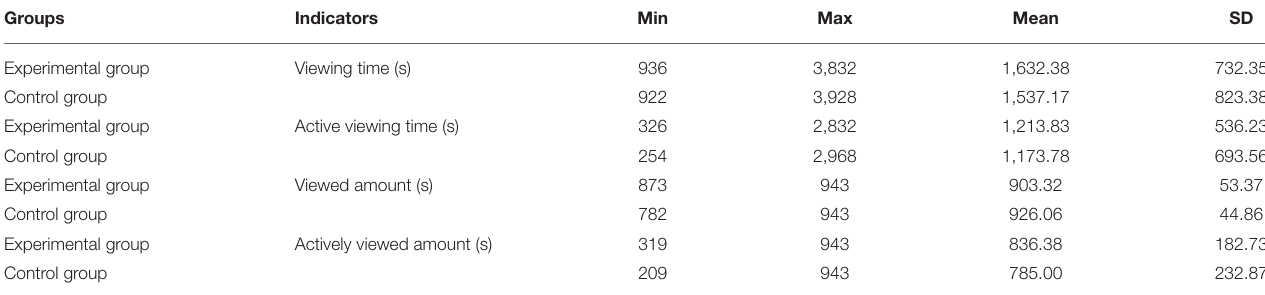
TABLE 3 | Descriptive statistics for the viewing behaviors of the two groups.